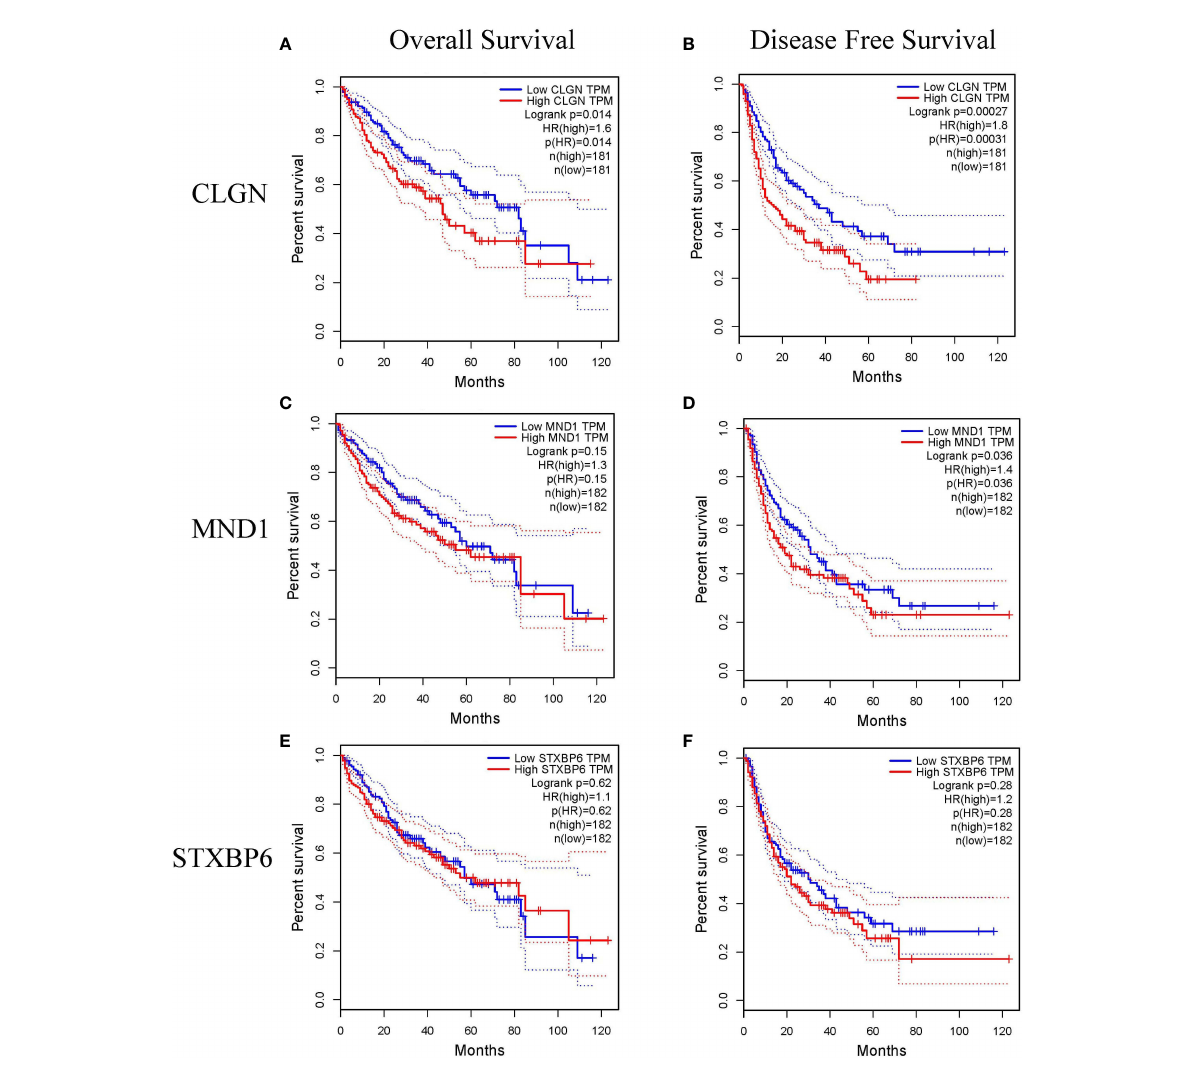
FIGURE 4 The relationship between the mRNA levels of MND1 , STXBP6 and CLGN and the prognosis of HCC (GEPIA). (A, B) HCC patients with higher mRNA levels of CLGN had poorer overall survival and disease-free survival ( p < 0.05). (C) No signi fi cant relationship between MND1 mRNA levels and patients ’ overall survival was observed ( p > 0.05). (D) Patients with higher MND1 mRNA levels had poorer disease-free survival ( p < 0.05). (E, F) There was no signi fi cant correlation between the mRNA levels of STXBP6 and overall survival and disease-free survival in HCC patients ( p >